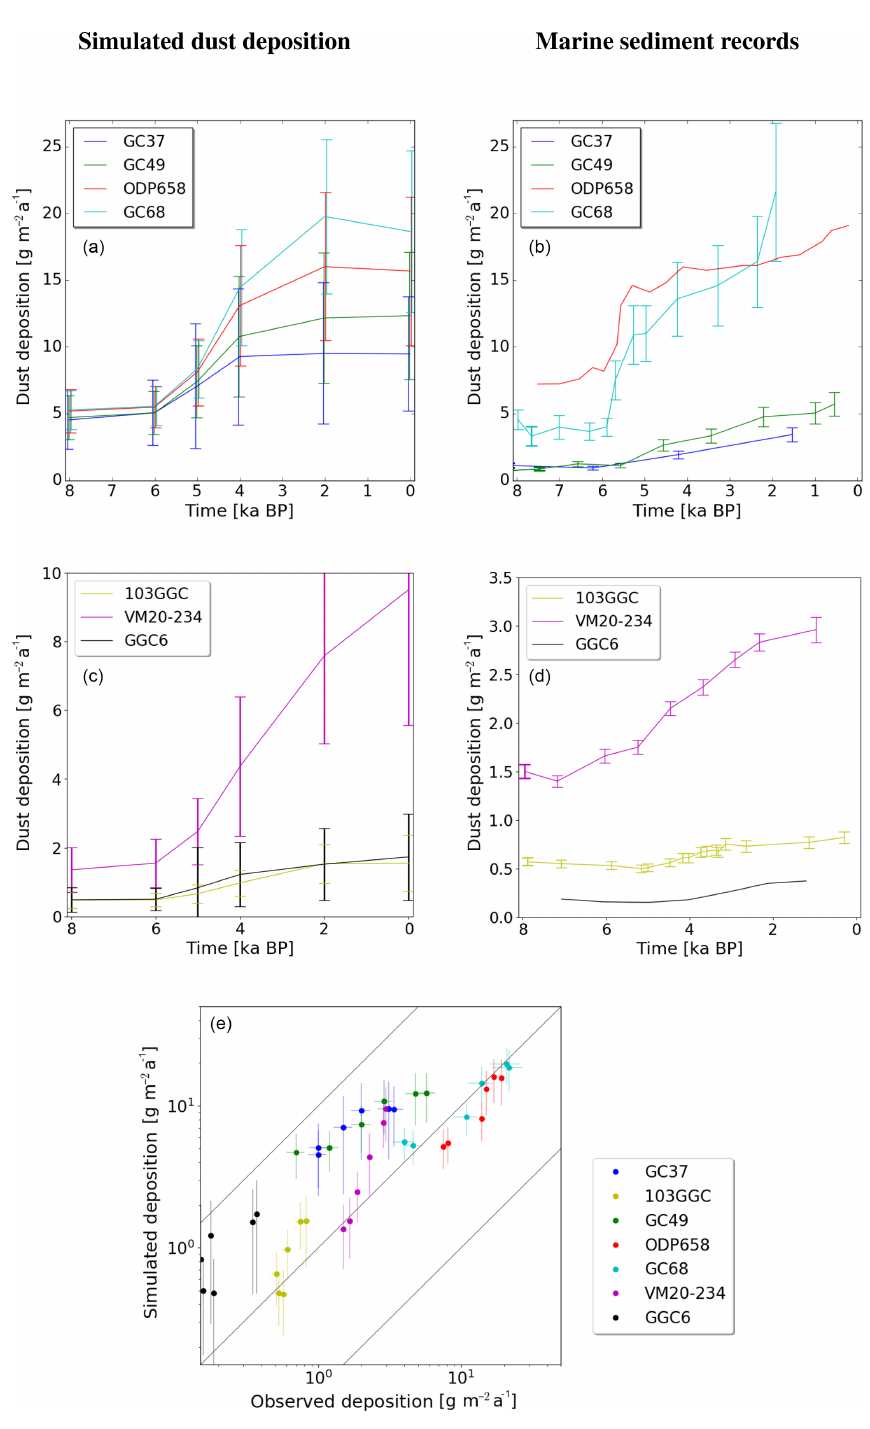
Figure 5. Comparison between simulated and observed dust fluxes at the position of the considered marine sediment cores. (a, c) Simulations. (b, d) Observations. Note that the scale is different for the remote core sites (plots in second row). For the data references see Table